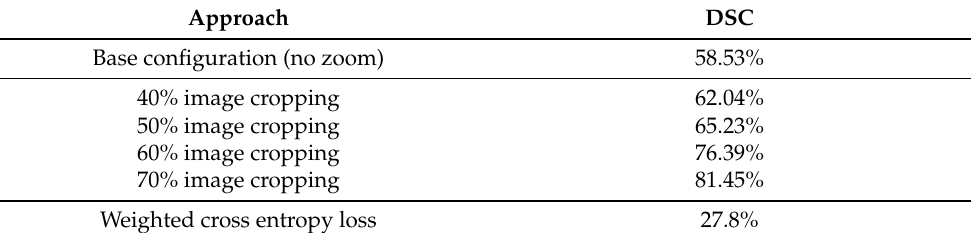
Table 2. DSC metric for different percentages of cropping of the original images (portal vein).